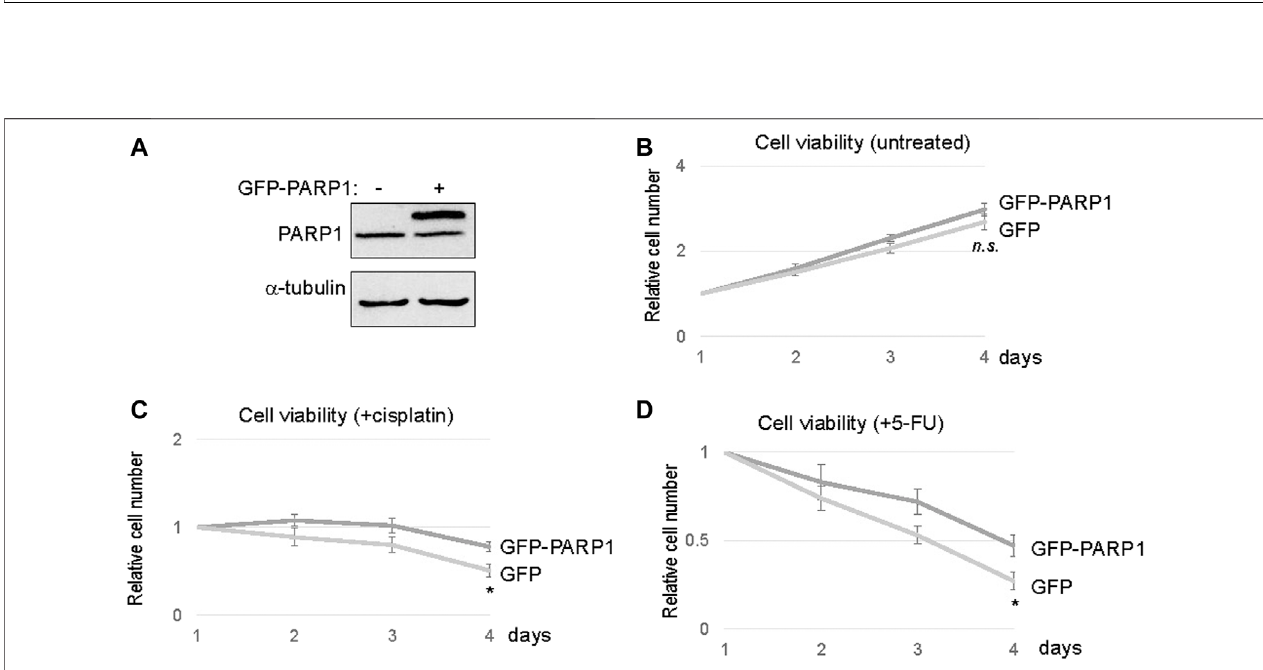
FIGURE 4 | PARP1 upregulation rendered SCC11A cells more resistant to chemotherapeutic drugs. (A) The expression of recombinant and endogenous PARP1 wasshownbyimmunoblotting. (B) SCC11AcellsexpressingGFP-PARP1orcontrolGFPvectorwereincubatedfor4 days.Cellviabilitywasdeterminedasdescribedin Materialsand Methods,thecellnumbers atdays 2 – 4werenormalized tothat atday 1.The meanvalues andstandardderivations,fromthree independentexperiments, wereshown. (C) SCC11AcellsexpressingGFP-PARP1orcontrolGFPvectorwereincubatedfor4days.Cisplatin(10 μ M)wasaddedatday1.Thecellnumbersat days 2 – 4 were normalized to that at day 1 (untreated). The mean values and standard derivations, from three independent experiments, were shown. (D) SCC11A cells expressingGFP-PARP1orcontrolGFPvectorwereincubatedfor4 days.5-FU(10 μ M)wasaddedatday1.Thecellnumbersatdays2 –